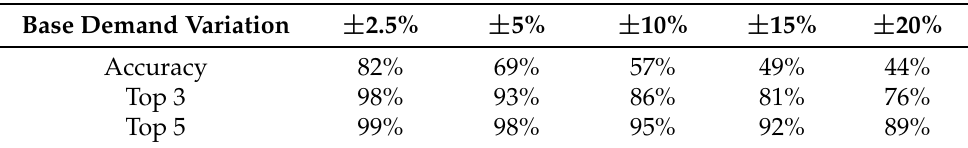
Table 2. Influence of base demand variation on model accuracy for the Hanoi network with an emitter coefficient range of 10–15 with 500,000